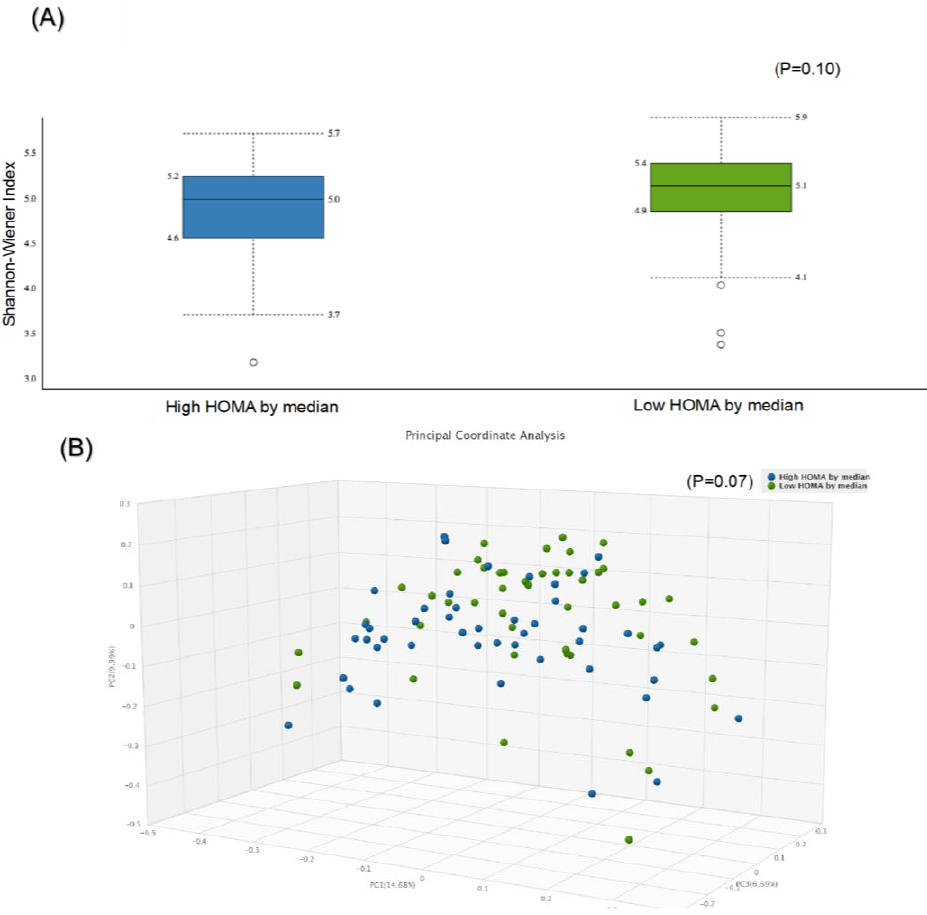
Figure 2. Comparison of bacterial diversities between the gut microbiota of the high HOMA group and the low HOMA group: ( A ) α -diversity, ( B ) β -diversity. The β -diversity using the paired Bray–Curtis similarity index indicated marginal significance between those with high compared to low HOMA-IR ( p = 0.07) (Figure